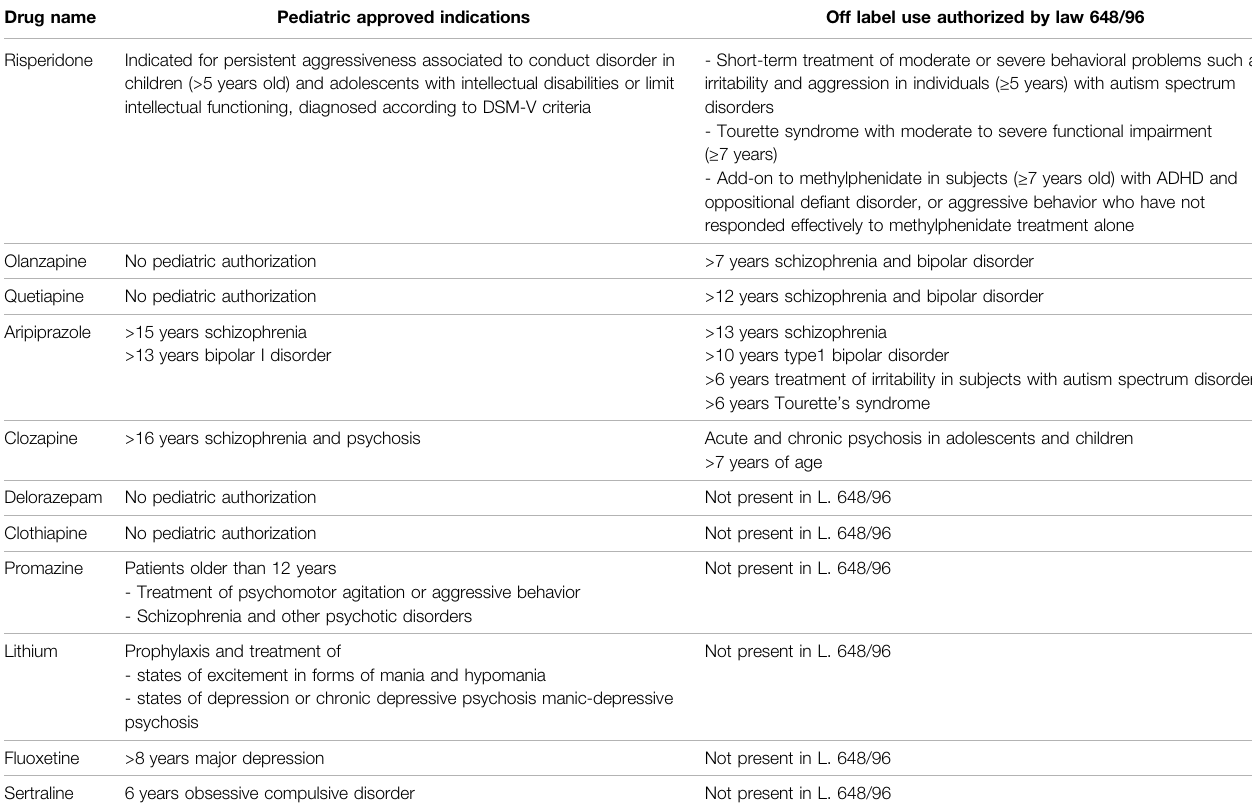
TABLE 2 | Authorized and reimbursed indications of antipsychotic drugs in Children and Adolescents in Italy. Drug name Pediatric approved